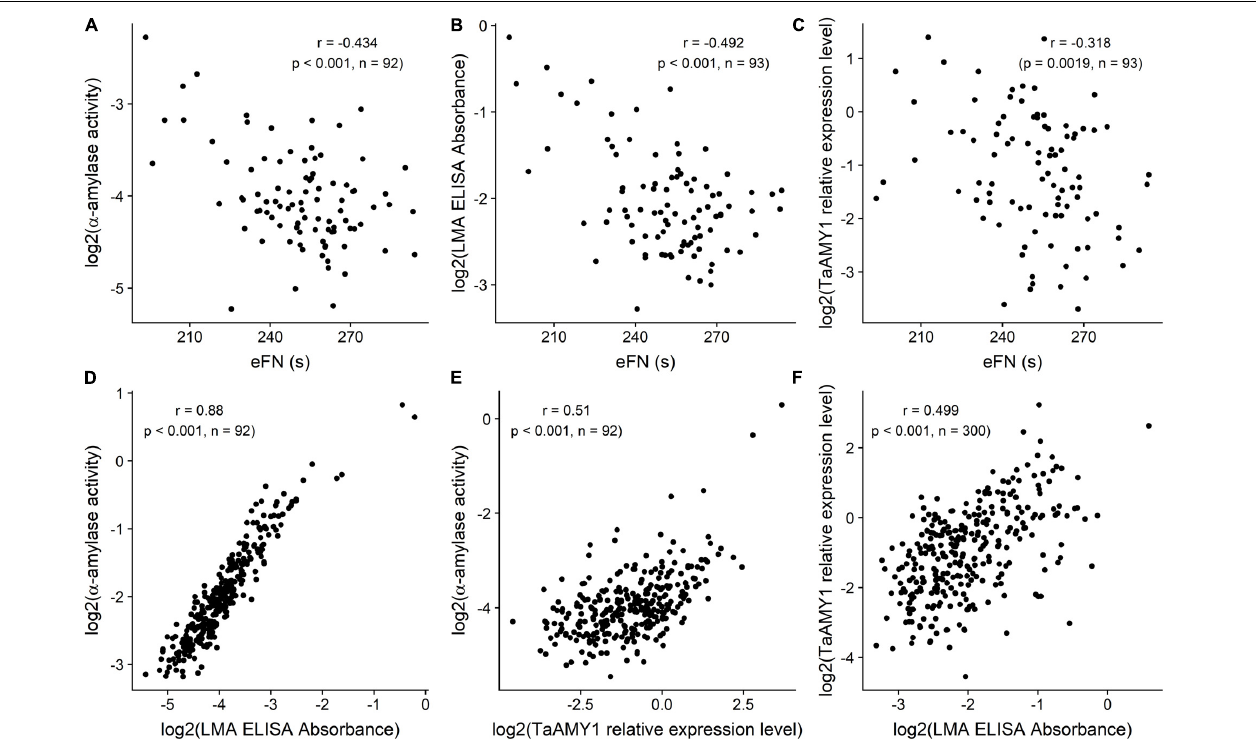
FIGURE 1 | Scatterplots and associated correlations ( r ) between equivalent Falling Number (eFN), and total a-amylase activity (A) , LMA ELISA Absorbance (B) , and TaAMY1 relative expression level (C) milled sample-level effects; between total a-amylase activity, and LMA ELISA Absorbance (D) and TaAMY1 relative expression level (E) ; between TaAMY1 relative expression level and LMA ELISA Absorbance (F) for wholemeal flour samples from the Yanco site. Falling Number is expressed in seconds. LMA Elisa is expressed as absorbance according to Verity et al. (1999) and TaAMY1 is expressed as relative expression to Actin (Log2). Amylase assay responses were available for n = 300 milled samples, but only n = 93 samples were available for eFN assessment. Plotted amylase assay responses are milled sample-level Best Linear Unbiased Predictors (BLUPs) from linear mixed model analyses of the data, while eFN values are based on raw stirring number data